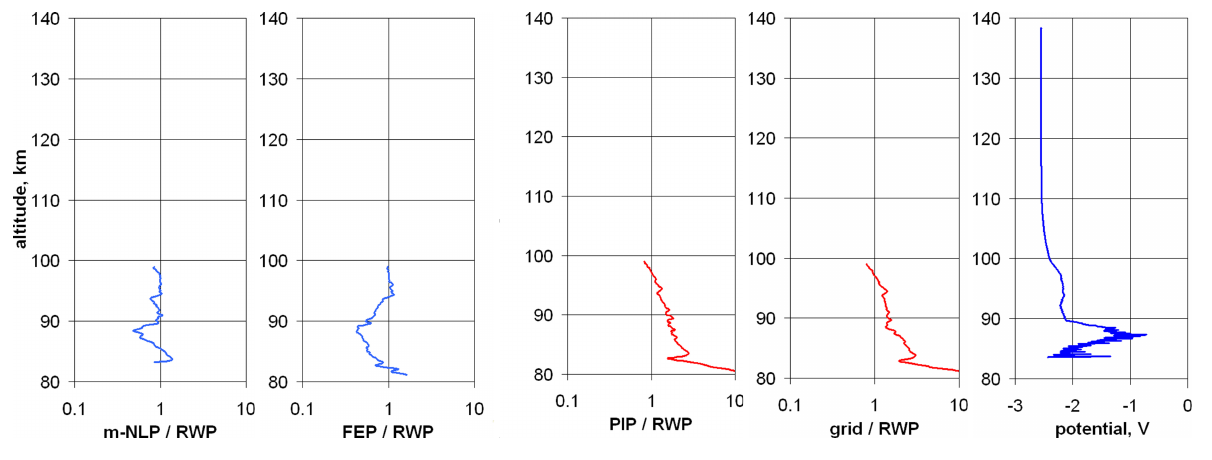
Fig. 7. As Fig. 4, but flight ECOMA-8.